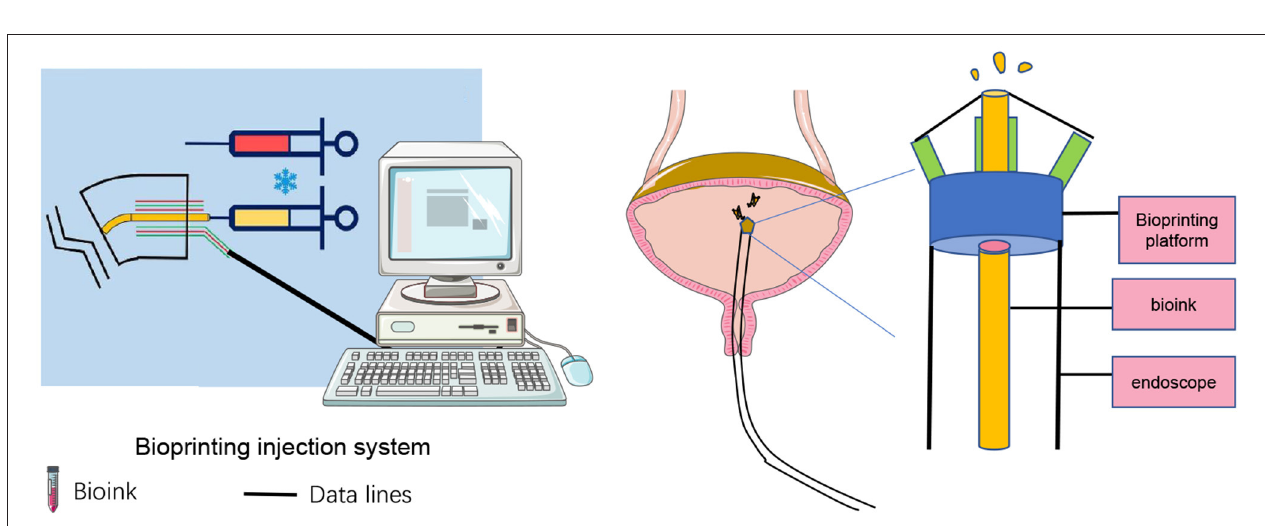
FIGURE 4 | Schematic of in situ in vivo bioprinting inside a